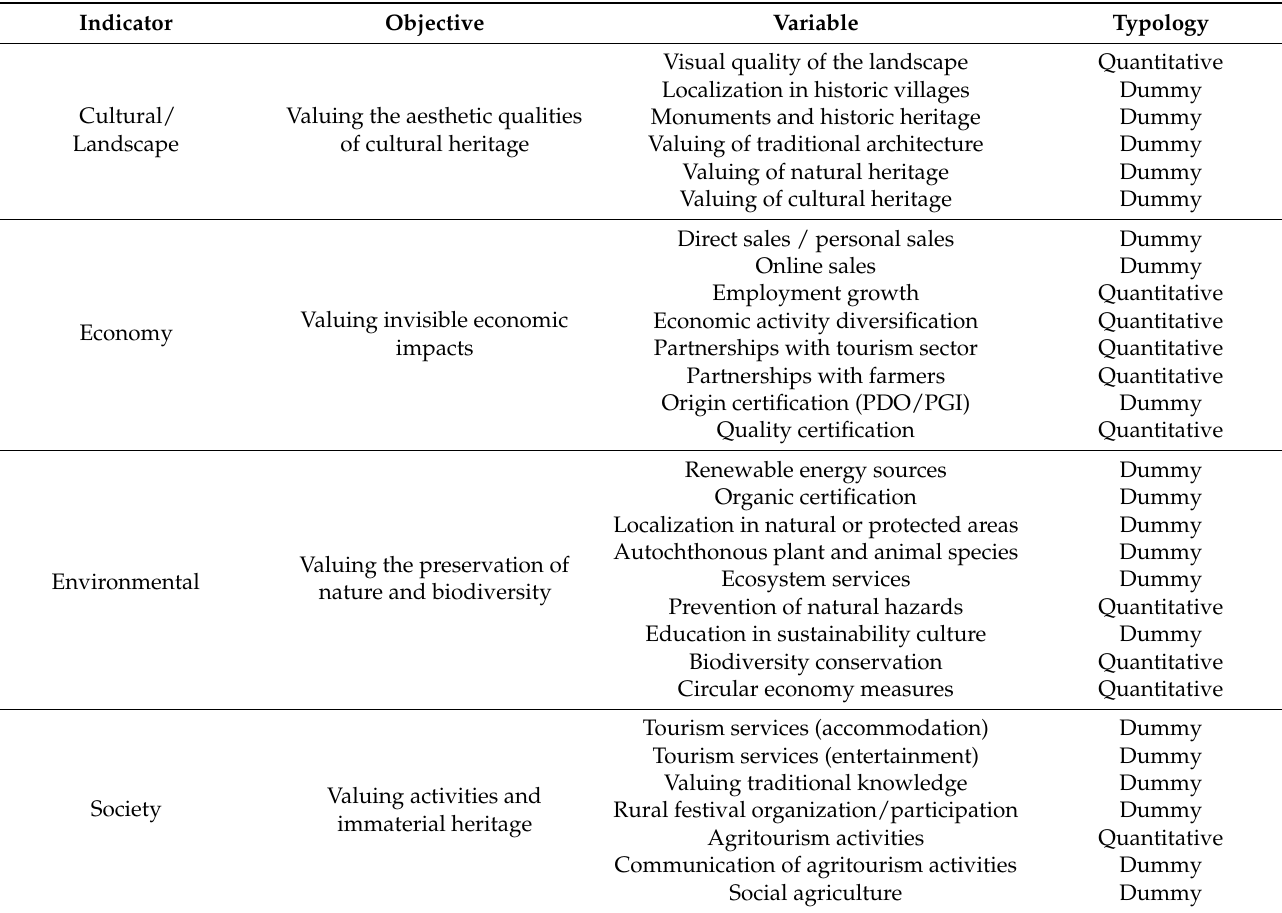
Table 3. Sustainable dimension and